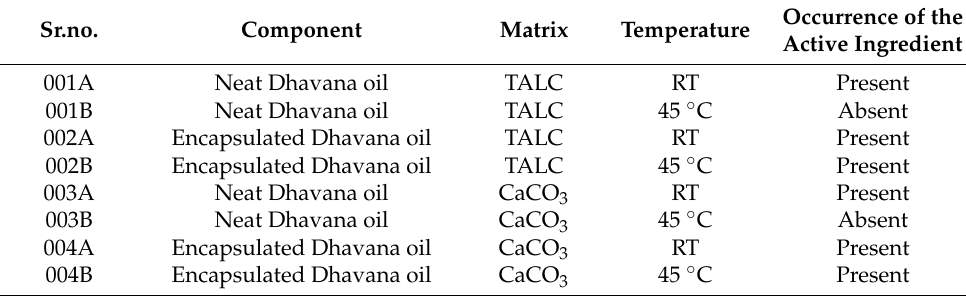
Table 8. Presence of active hydroxydhavanone from neat and encapsulated Dhavana oil in TALC